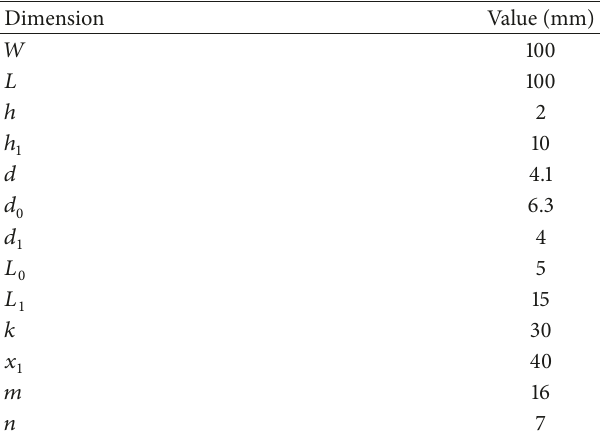
Table 1: Design parameters with final optimized dimension of the antipodal Vivaldi antenna.